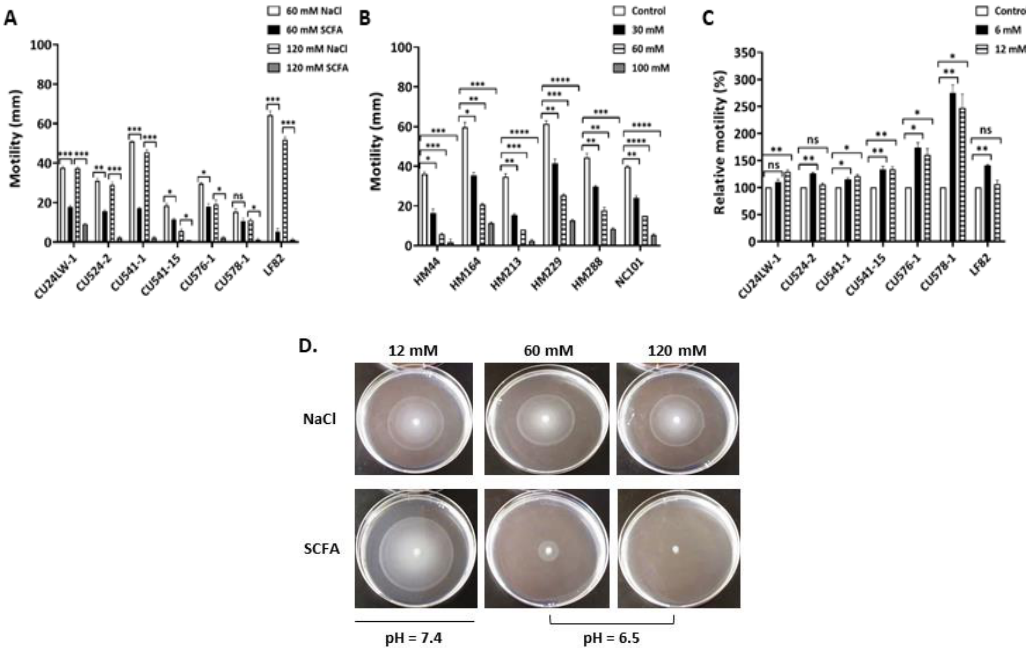
Figure 5. E. coli motility was inhibited by c-SCFA but promoted by i-SCFA. Soft agar was used to measure the swarming ability of E. coli under either colonic (( A ), ( B ) and ( D ); pH = 6.5) or ileal (( C ) and ( D ); pH = 7.4) conditions. D. Images of swarming AIEC CU541-1. Mean ± SD; * p < 0.05; ** p < 0.01; *** p < 0.001; ns = not significant.